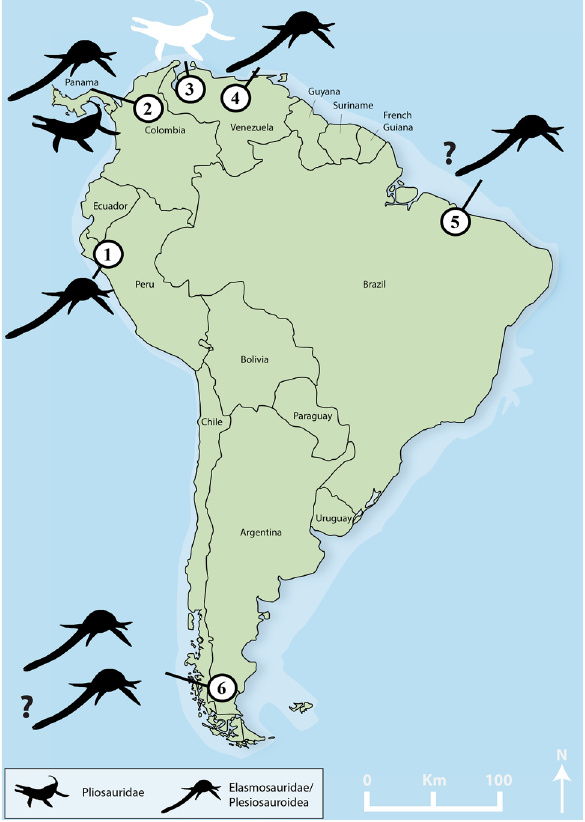
Figure 2. Distribution of mid-Cretaceous (Aptian-Turonian) plesiosaurs in South America. The new pliosaurid from the La Luna Formation is highlighted. ( 1 ) Jaén area, Romirón Fm., Peru; ( 2 ) Villa de Leiva, Paja Fm., Colombia; ( 3 ) Cementos Andinos Quarry, La Luna Fm., Venezuela; ( 4 ) Altagracia de Orituco area, Querecual Limestone, Venezuela; ( 5 ) Near Sao Luis, Alcântara Fm., Brazil; ( 6 ) Santa Cruz Province, Mata Amarilla Fm., Argentina. See Table 1 for details and references (map provided with permission by PD Dr. Torsten M. Scheyer; modified by Dylan Bastiaans using Adobe Illustrator & Photoshop [v2021.25.0]).